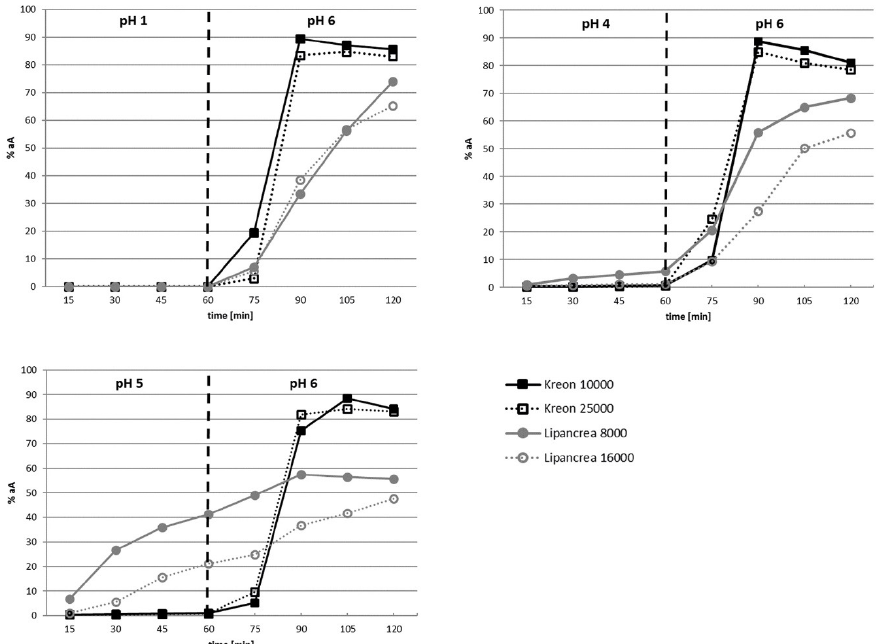
Figure 2. Kinetics of enzyme release at pH 1.0, 4.0, 5.0 and 6.0. NOTE: on the y -axis, the enzyme amount is normalized to the actual assay of the respective product to compensate for different strengths (as per label claim) but also for overages up to 10%, which have been observed in the assay (compared with Table 2). The vertical dotted line represents the change in pH.